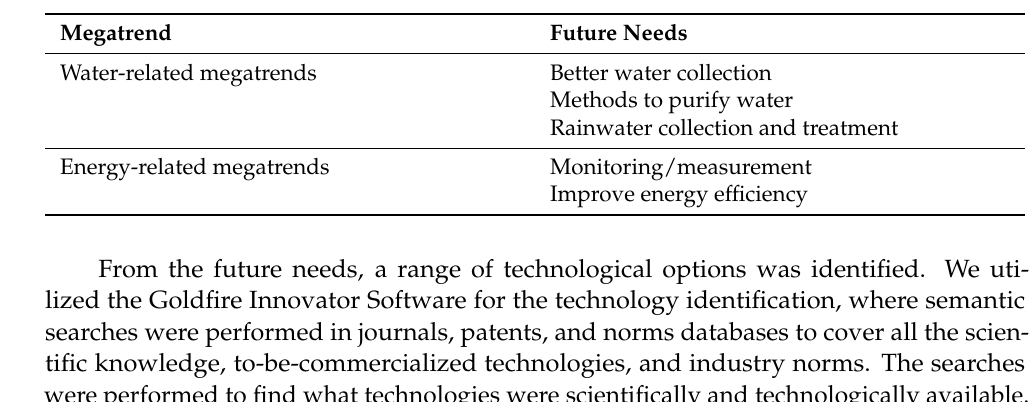
Table 2. Exemplification of the relationship between a megatrend and future